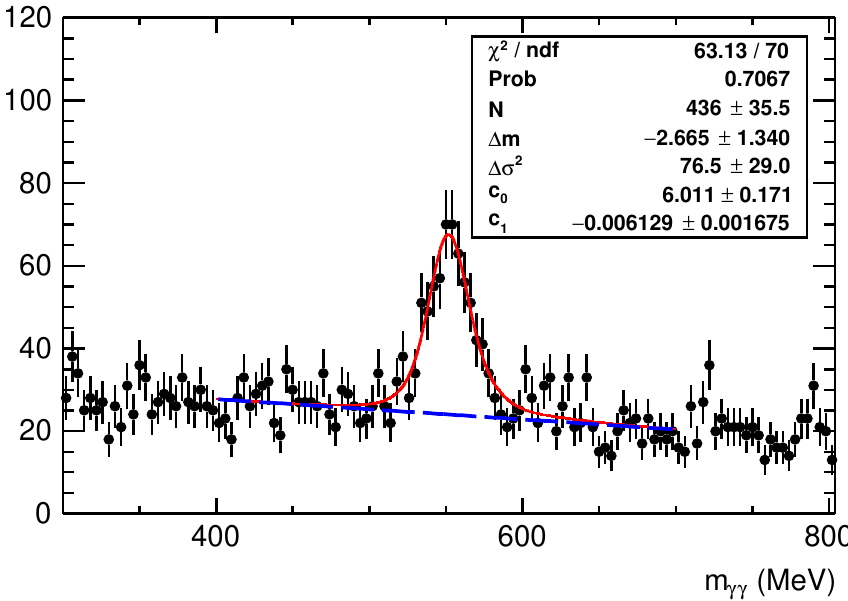
Figure 3 . Two-photon invariant mass spectrum for the experimental data events (points with p error bars) at s = 1 : 5 GeV (cid:12)tted with the function (solid curve), which contains the signal and background (dashed curve)